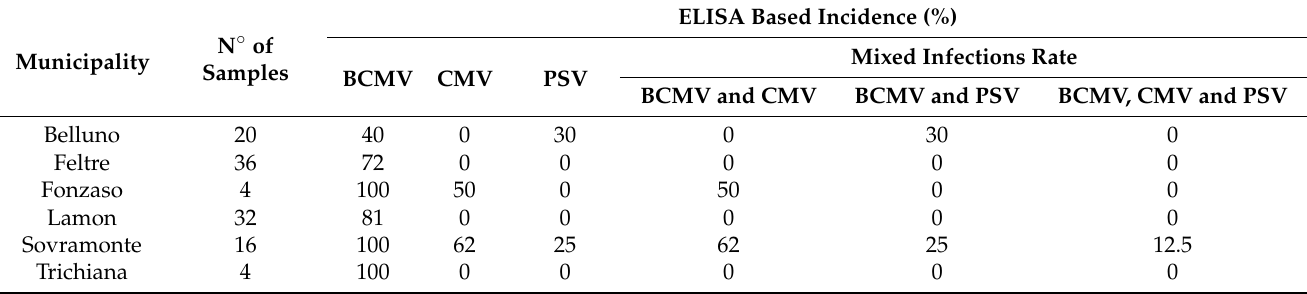
Table 2. Sampling location, and infection rate of BCMV, CMV and PSV determined by ELISA in Lamon bean samples collected in August